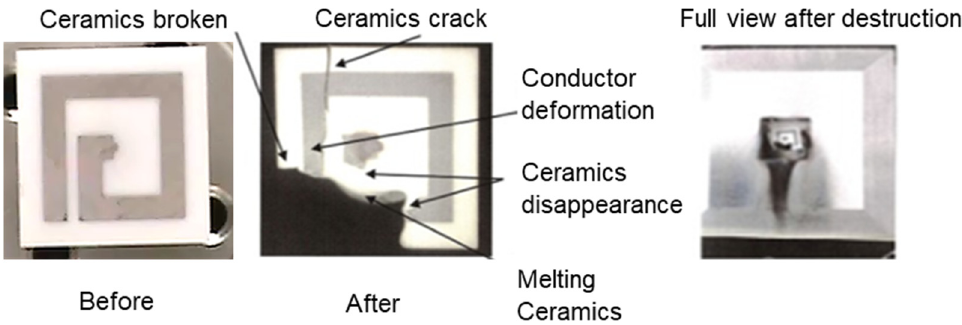
Figure 16. Failure analysis shows ceramic melting after 4 A current surge. Normal operations only require 0.3 A.